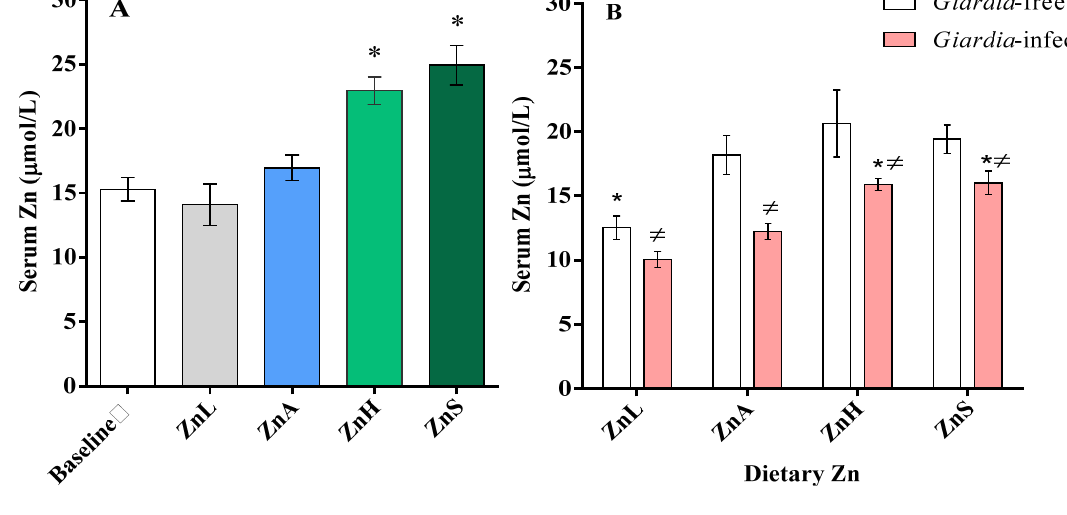
Figure 2. Effects of dietary zinc and infection on serum Zn concentration. Zinc levels in serum of mice following a 10-day feeding period ( A ) and of Giardia -free and Giardia -infected CD-1 mice following an additional 30-day feeding period p.i. ( B ) with diets containing 10 mg Zn/kg (ZnL), 30 mg Zn/kg (ZnA), 223 mg Zn/kg (ZnH)